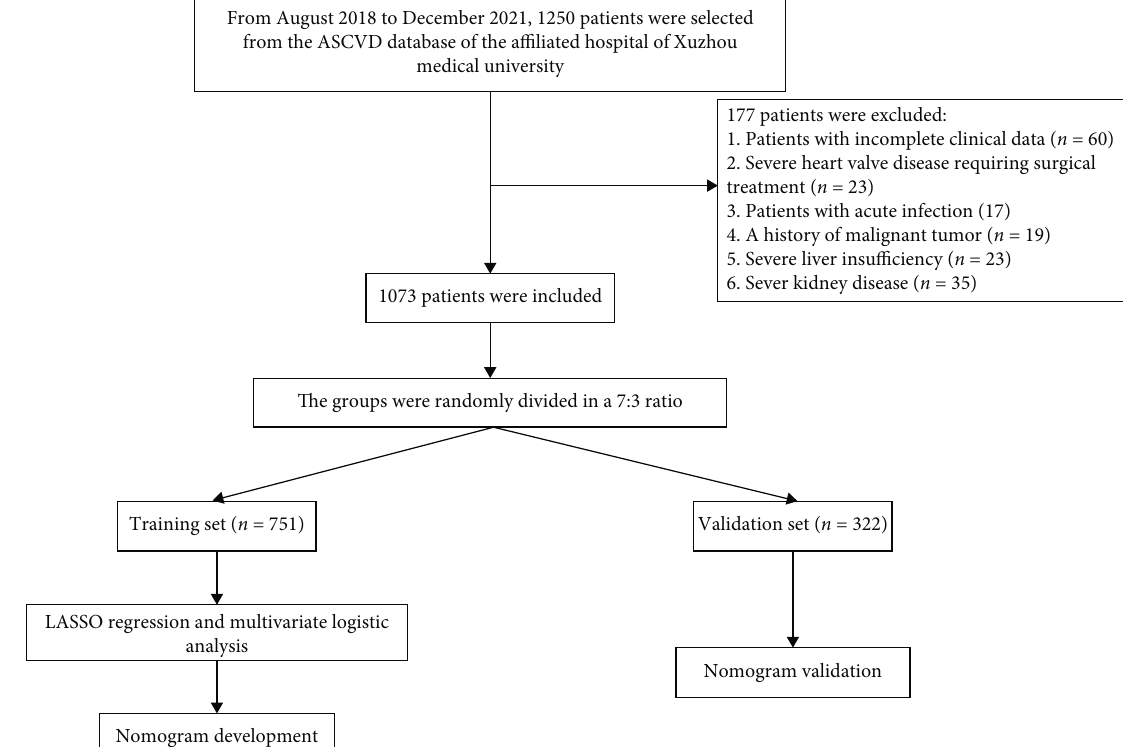
Figure 1: Flow chart of the inclusion and exclusion process of patients with ASCVD and diabetes mellitus. Abbreviation: ASCVD: atherosclerotic cardiovascular